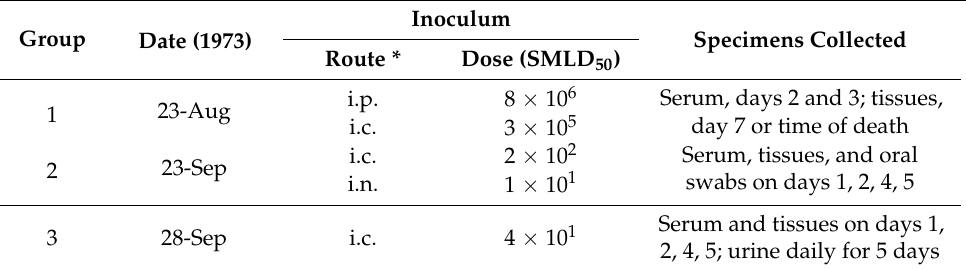
Table 1. Groups of bats experimentally inoculated, routes and doses, and specimens collected.